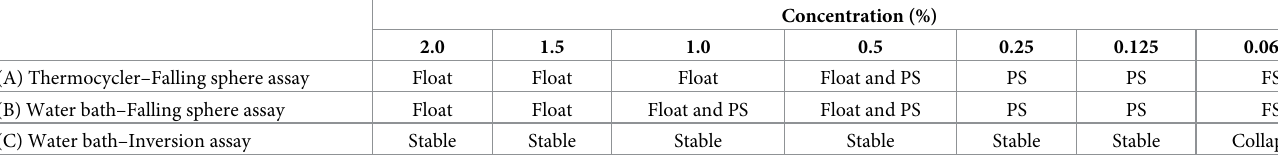
Table 3. Gelation results of calcium-supplemented low acyl gellan